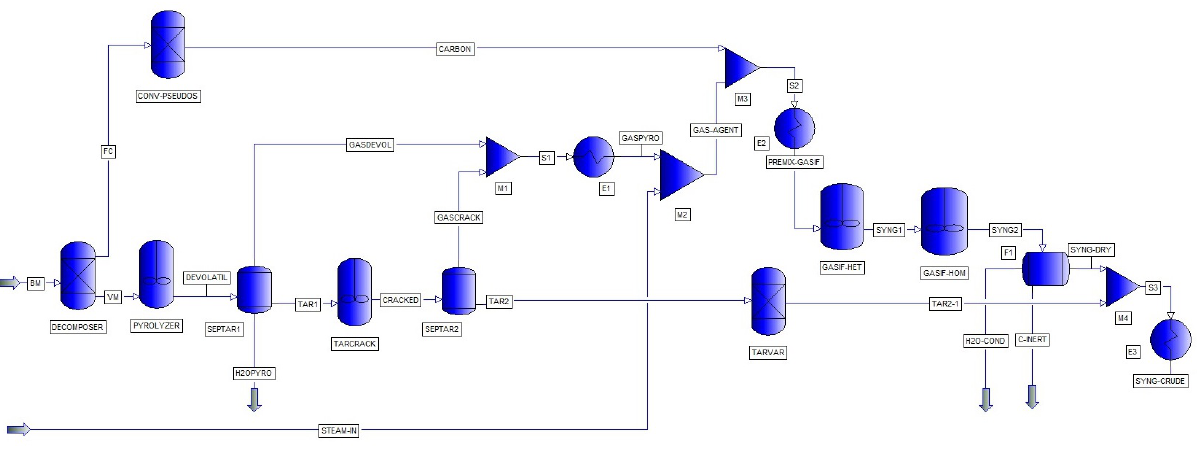
Figure A2. Flow diagram for the KinetM model in